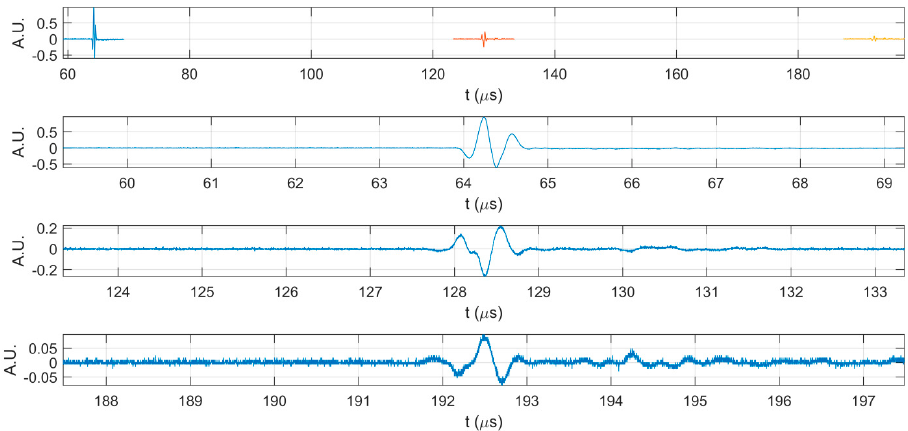
Figure 5. The first three echoes acquired for CD-HAp_2 sample.